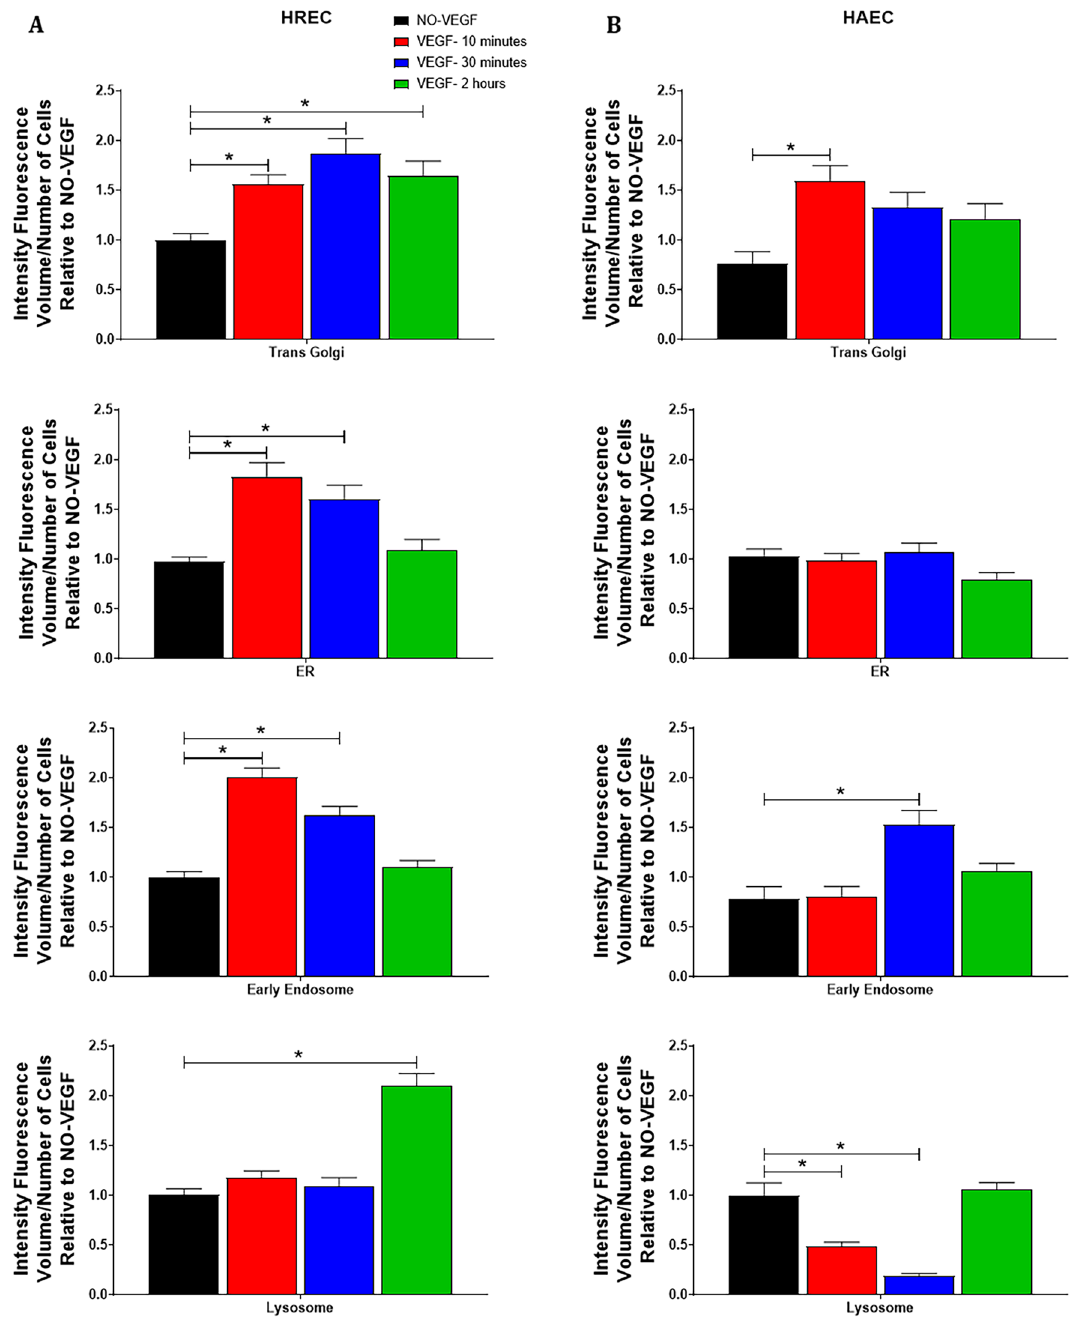
Figure 6. VEGF changes the volume of intracellular organelles . Trans Golgi, endoplasmic reticulum (ER), early endosome and lysosome density was measured in HREC and HAEC by the quantification of the MIF relative to the area occupied by each organelle and divided by the number of cells. Graphs depict quantification of organelles density of at least 10 confocal z-stack images at 400 × magnification for each experiment performed using NIS elements software. Data for each VEGF time point was normalized to the control NO-VEGF and the graphs show the average from a minimum of 3 separate experiments from 3 donors of the HREC and 2 donors of the HAEC. * = p < 0.05 as determined by 1-way ANOVA and multi-comparison post-hoc Tukey’s test is considered